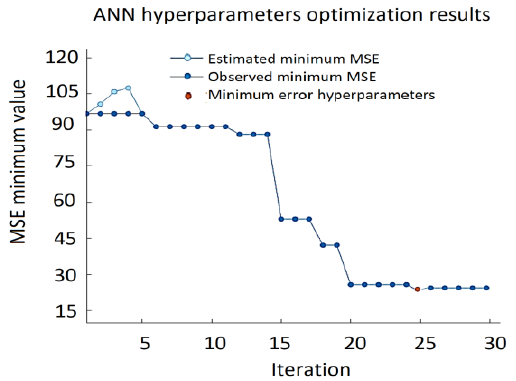
Figure 13. Minimum MSE during ANN hypermeters’ optimization process.